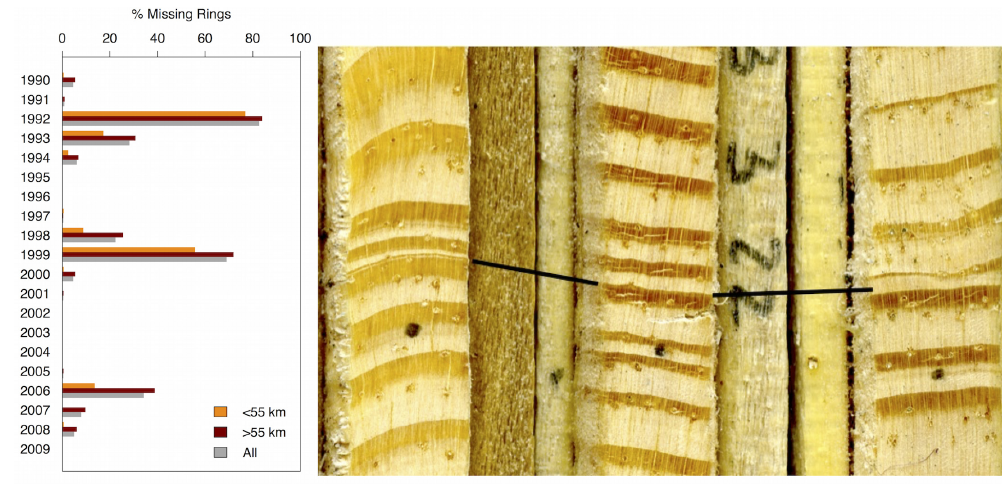
Fig 2. Missing rings. Left: Annual percentage of total missing rings across all series (including all seed sources; gray), local seed sources ( < 55 km away from the plantation site; orange), and distant seed sources ( > 55 km from the plantation; red). Right: Scanned image of pitch pine cores with lines pointing to the year 1992, which is apparent in the far-left tree core as a micro ring, almost imperceptible in the middle core, and clearly evident in the far right